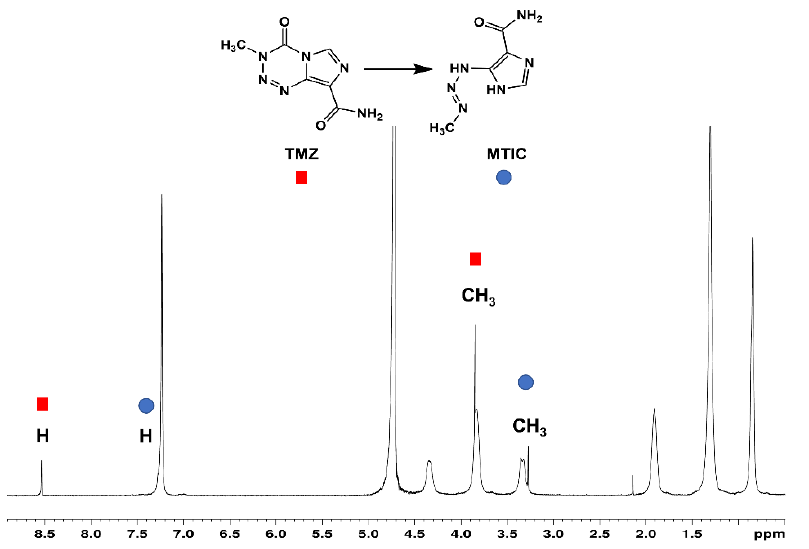
Figure 6. 1 H NMR spectra of SC4OC6/TMZ (7.4 mM/4.5 mM) after incubation for 6 h at 37 °C. TMZ signals (red square) and MTIC signals (blue circle).